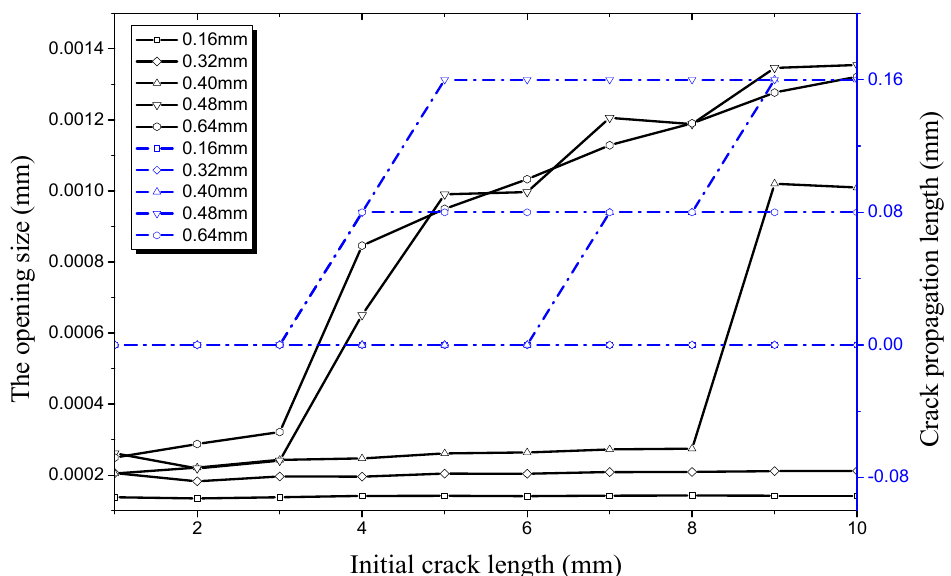
Figure 23. Relationship between radial crack propagation length and initial crack length on the inner surface, and relationship between radial opening size and initial crack length on the inner surface, both under an internal pressure of 21 MPa.